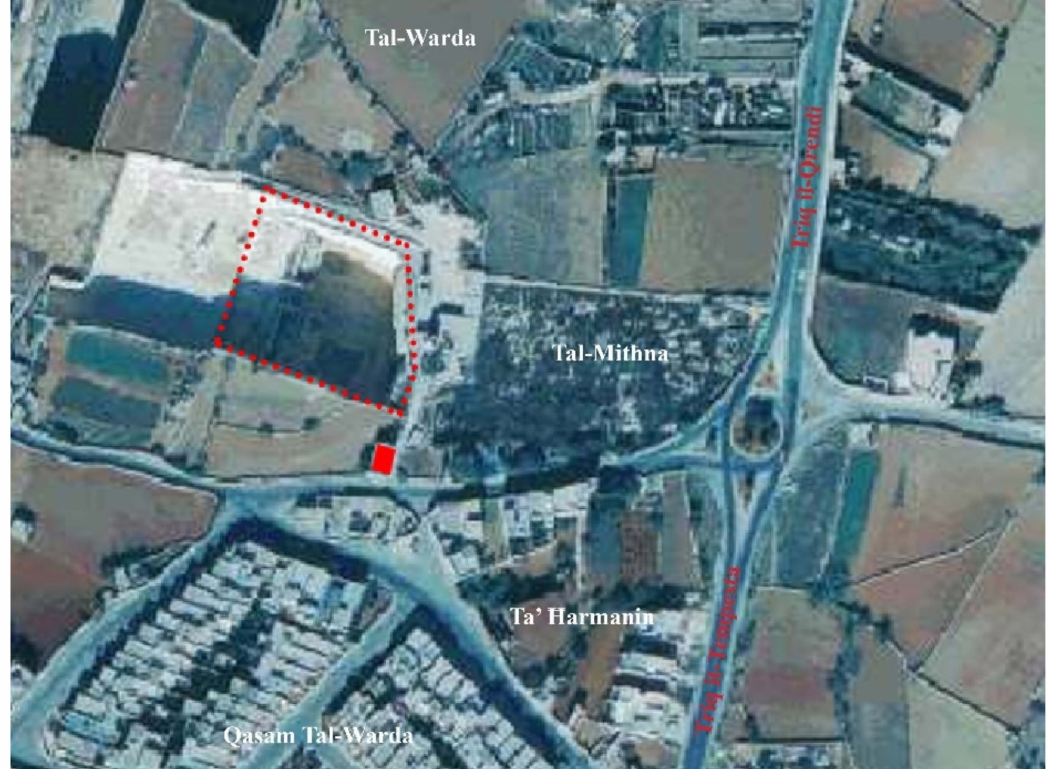
Figure 4. Aerial imagery, dated 1998, of Tal-Warda quarry (outlined in red) and the Chapel of St Catherine (in red) [83]; for the location of site with respect to Malta, see Figure